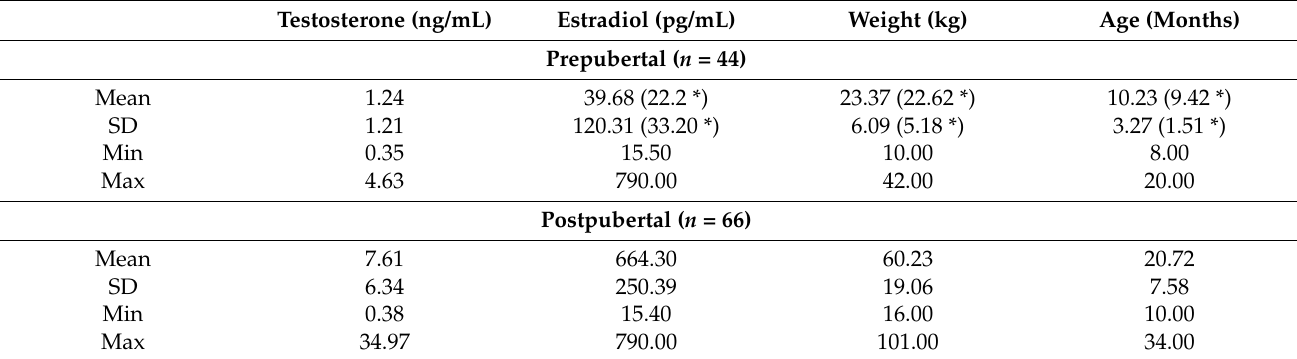
Table 1. Mean concentrations of testosterone and estradiol, as well as weight and age data, with relative standard deviation (SD) for prepubertal and postpubertal wild boar